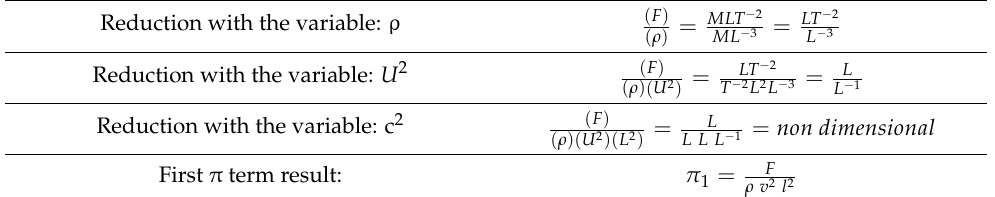
Table 5. Dimensional analysis first term found.